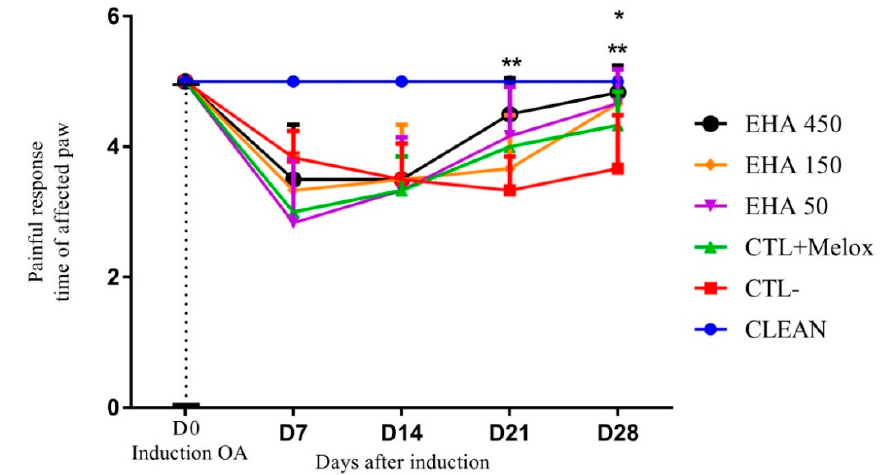
Figure 5. Effects of A. chica extract on mechanical allodynia in rats with induced osteoarthritis (OA). The induction of OA was made by the injection of MIA (2 mg) in the right knee of Wistar rats. After 3 days, the animals received oral saline (CTL − ), Meloxicam (CTL + Melox) and A. chica extract at doses 50, 150, and 450 mg/kg (EHA50, EHA150, and EHA450). After 7, 14, 21, and 28 days of OA induction, mechanical allodynia was measured by indirect evaluation with the von Frey test. The data are represented in mean ± standard deviation of the means. The healthy group is represented by animals without osteoarthritis and without treatment (CLEAN). * represents significant differences, with p < 0.05; ** with p < 0.005 comparing the treatments to the saline group.